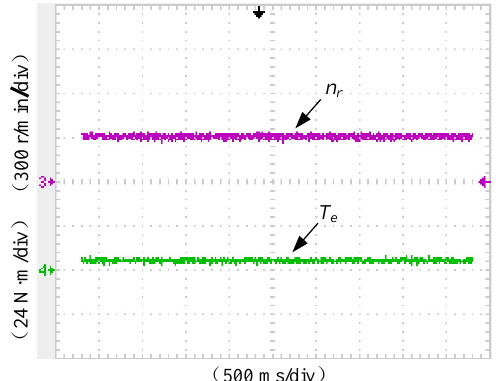
Figure 18. T e and n r of the MTFTSFPM machine under open-circuit fault using RDTC.